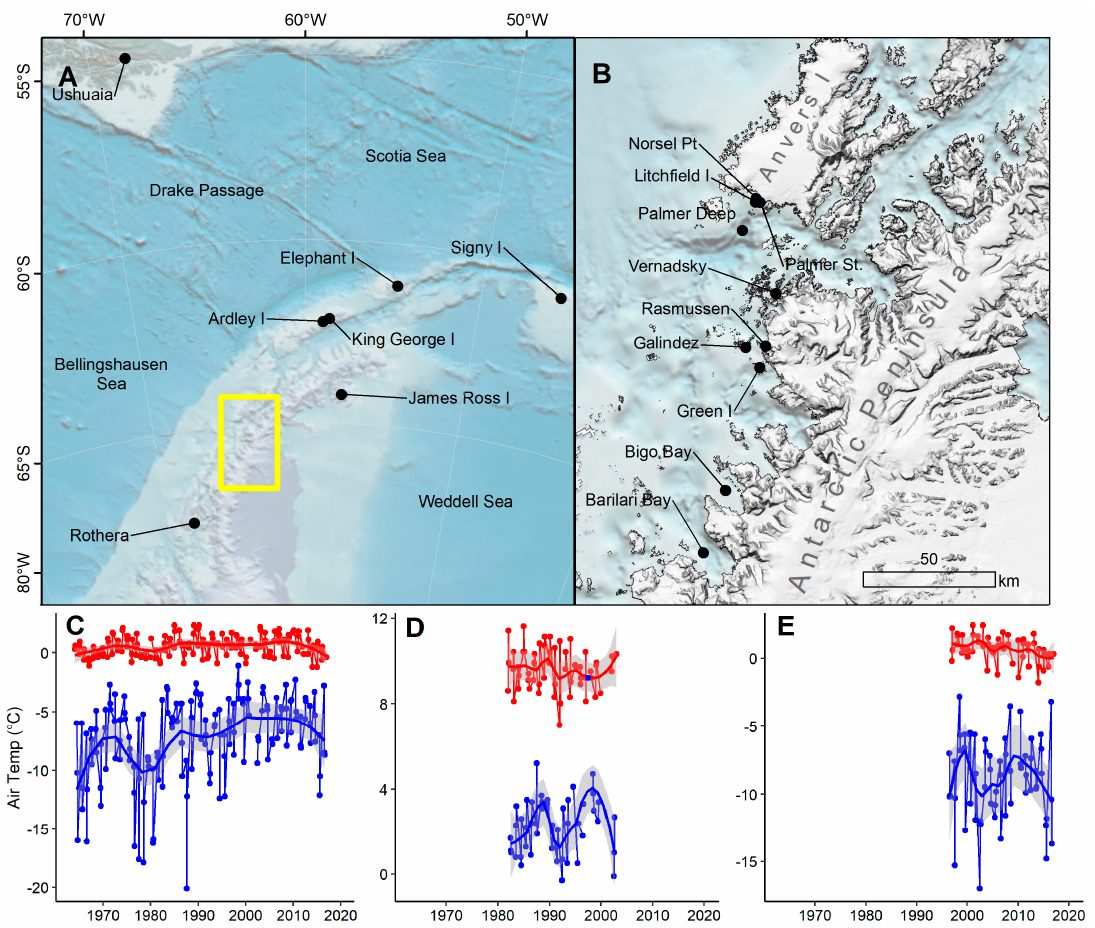
Figure 1. Antarctic Peninsula (AP) regional map and climate data: ( A ) Locations mentioned in text for the maritime Antarctic region and southern South America (yellow box shown in panel B); ( B ) locations of climate and paleoclimate records in the western AP near our study site, Litchfield Island; ( C – E ) air temperature data for summer (red) and winter (blue) for ( C ) Vernadsky Station (UKR), ( D ) Ushuaia (ARG), and ( E ) and Rothera Station (GBR). All weather station data are from [11], bathymetry sourced from [12] and digital elevation model from [13].